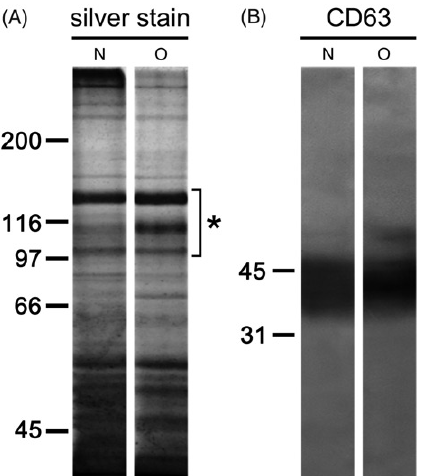
Figure 2. Protein composition of seminal prostasomes. Seminal prostasomes isolates were resolved on 10% SDS-PAGE under reducing and denaturing condi- tions and stained with silver or transferred onto a membrane and subjected to immuno-blot. A: A representative total protein pattern of seminal prostasomes with three characteristic bands (12) in the region of 90 – 150kDa (asterisk). B: CD63, an EVs-associated marker gave characteristic smeared band above 31kDa. The numbers indicate the position of molecular mass standards (kDa). (N ¼ seminal prostasomes from normozoospermic men; O ¼ seminal prosta- somes from oligozoospermic